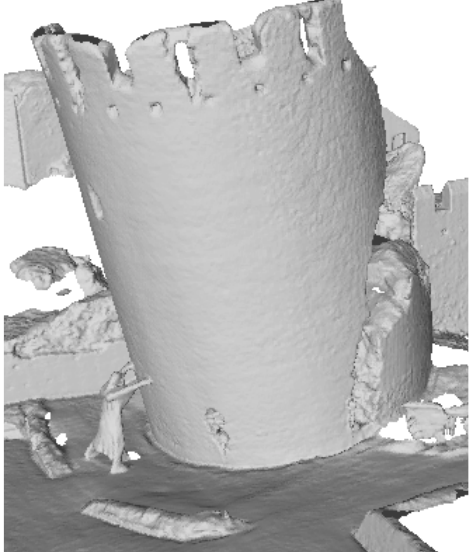
Figure 4. Rough points cloud.